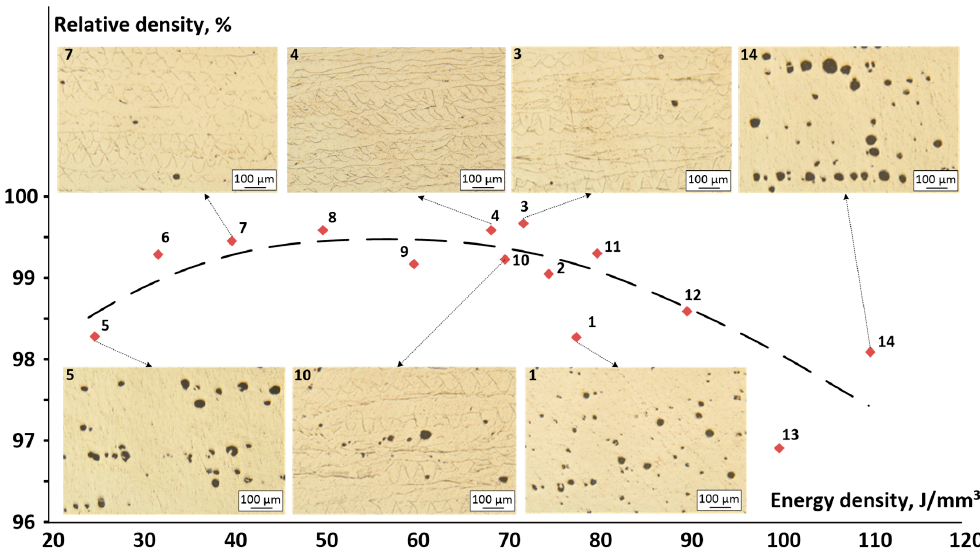
Figure 4. Relative density of the Ti-18Zr-14Nb specimens as a function of the laser energy density.